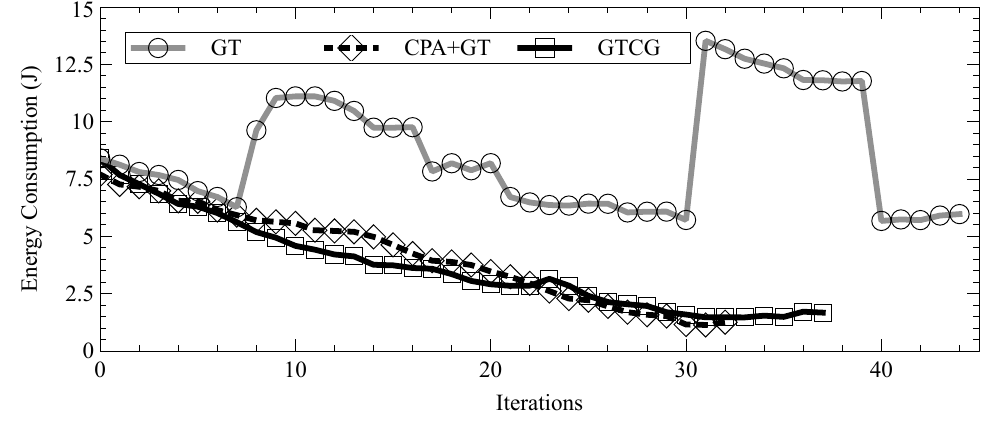
Figure 11. Convergence